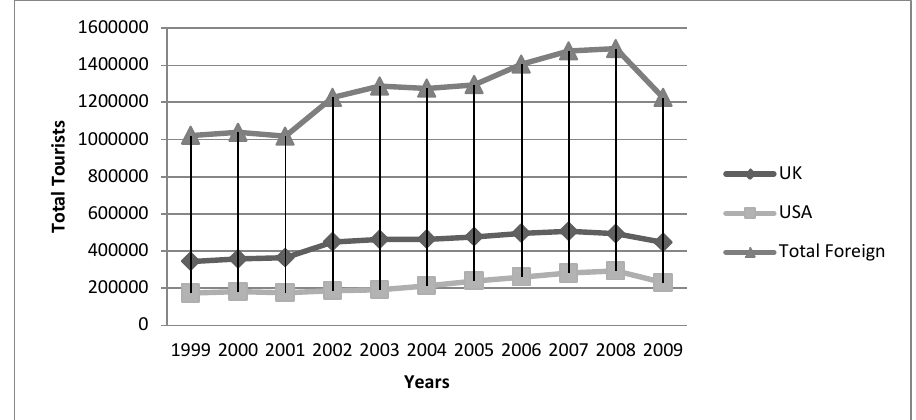
FIGURE 1: Foreign Tourist Arrivals Source Statistics South Africa (P0351 various